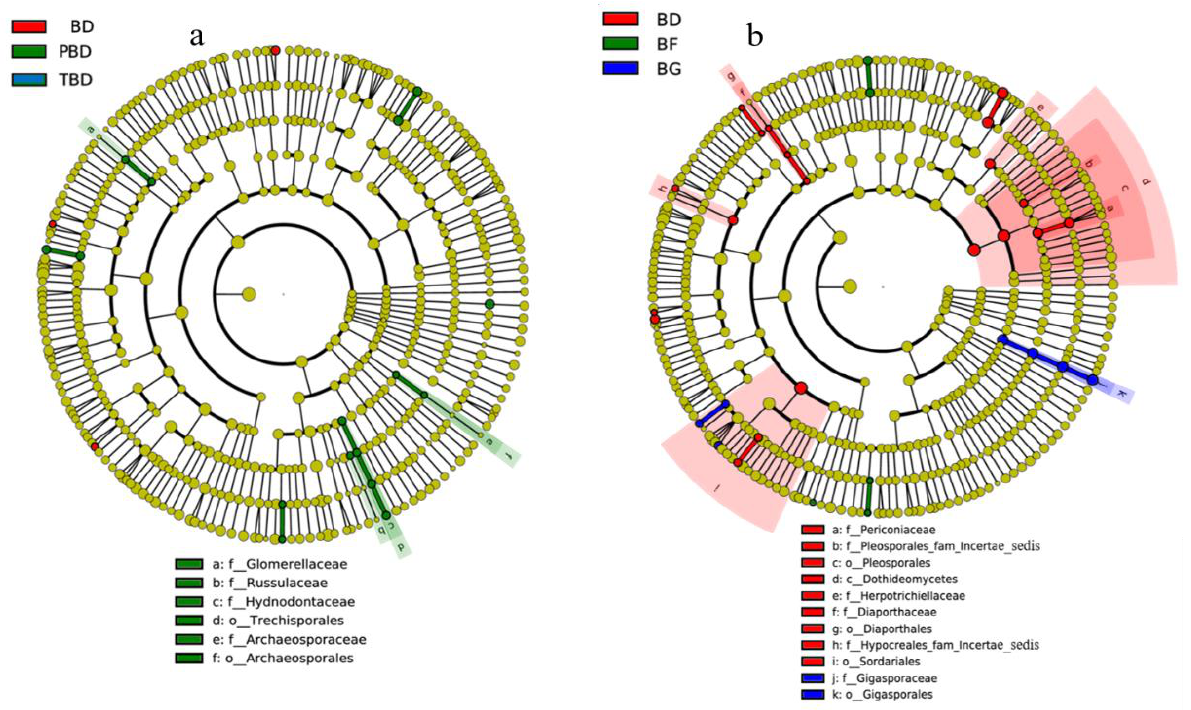
Figure 4. Linear discriminant analysis effect size (LEfSe) of the fungal community in the different treatments. Fungal biomarkers with significantly different LDA scores > 2 among different cover crops–biochar–organic fertilizer treatments ( a ) and different biochar–organic fertilizer treatments ( b ) groups are listed. In the evolutionary branching diagram, the circles radiating from inside to outside represent taxonomic levels from phylum to genus. Different colors indicate different treatments, and species with no significant differences are uniformly colored yellow; if a group is missing in the figure, it indicates that there are no species with significant differences in this group. The names of species indicated by letters in the figure are shown in the legend below it.